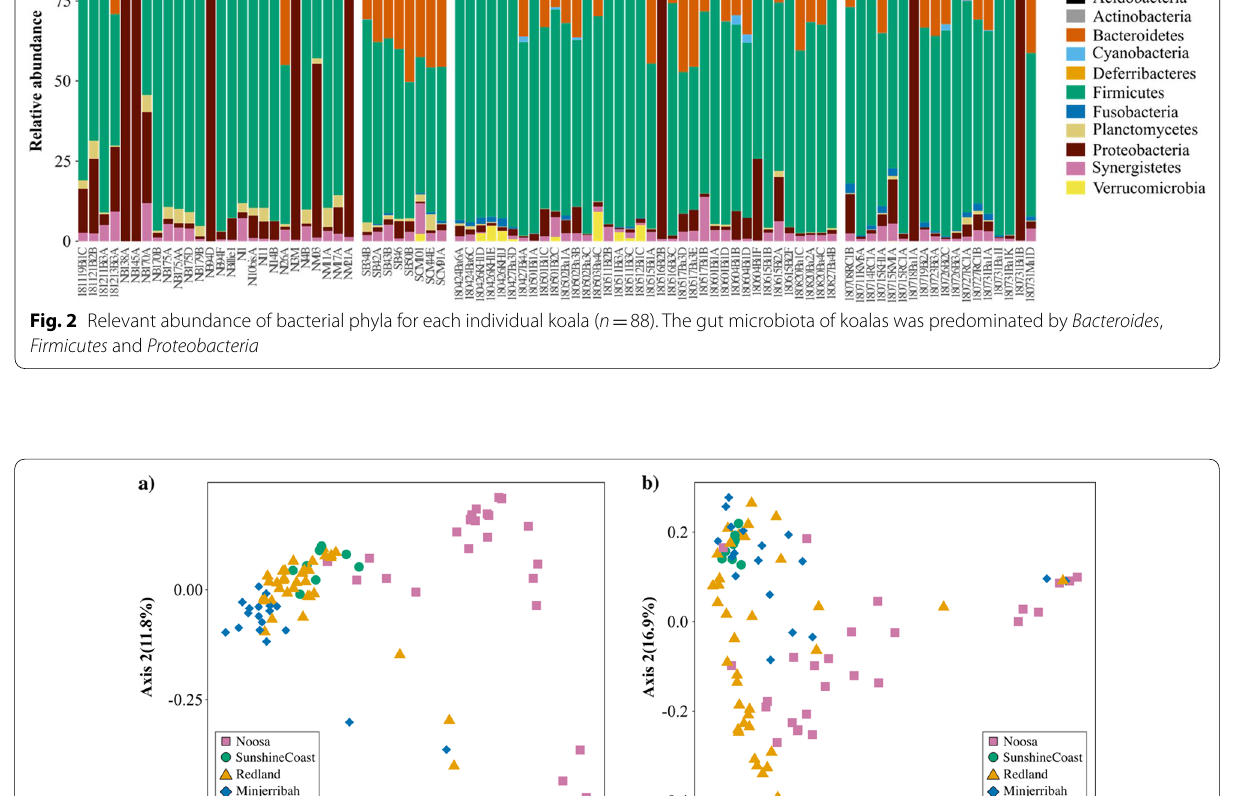
Fig. 3 Location was found to significantly influence ( P < 0.001) koala a gut bacterial community membership (unweighted UniFrac) and b gut bacterial community structure (weighted UniFrac) across South East Queensland, Australia. Significance between locations was determined using PERMANOVA tests. Each dot point represents the microbial profile of an individual koala ( n =